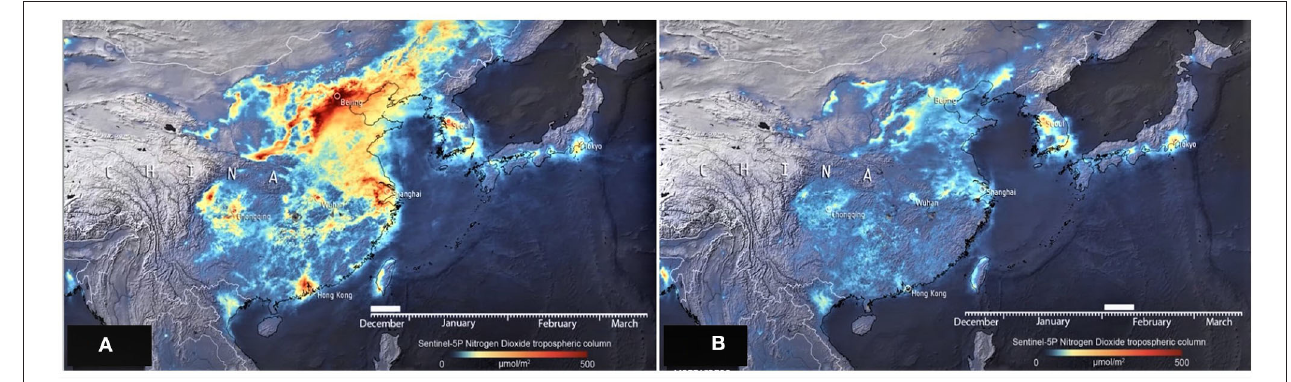
FIGURE 2 | NO 2 drops down in the coronavirus epicenter Wuhan, Hubei Province -China. (A) In December 2019, (B) February 2020